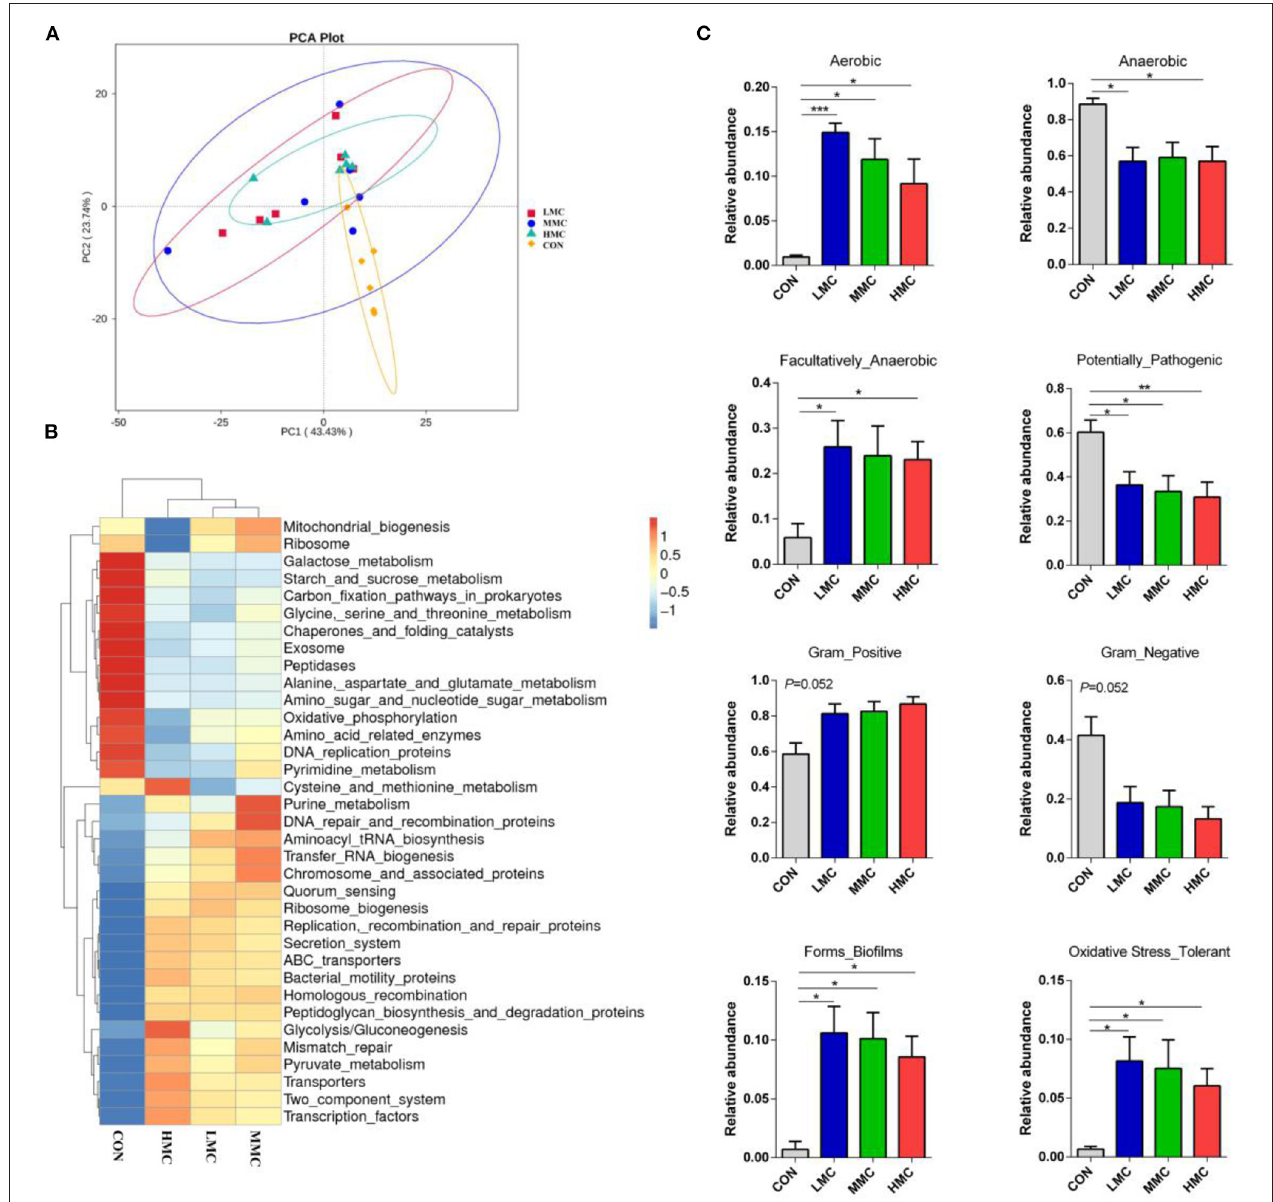
FIGURE 6 | Dietary supplementation of Moutan cortex radicis altered the metabolic functions and phenotypes of colonic microbiota in the pigs. (A) Principal components analysis (PCA) of functional profiles in the gut microbiota; (B) The heatmap tree based on different metabolism-related pathways at KEGG level 3; (C) The metabolic phenotypes prediction were compared using BugBase online (https://bugbase.cs.umn.edu/). The relative abundances of discrete phenotype were performed using pair-wise Mann-Whitney U -tests. Data are expressed as means ± SEM ( n = 6). CON, control group, basal diet without antibiotics; LMC, the control diet + 2,000 mg/kg Moutan cortex radicis ; MMC, the control diet + 4,000 mg/kg Moutan cortex radicis ; HMC, the control diet + 8,000 mg/kg Moutan cortex radicis . * P < 0.05, ** P < 0.01, and *** P <